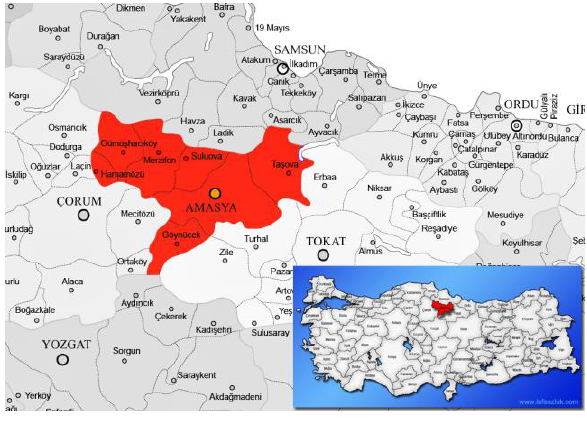
Figure 1. Project Area